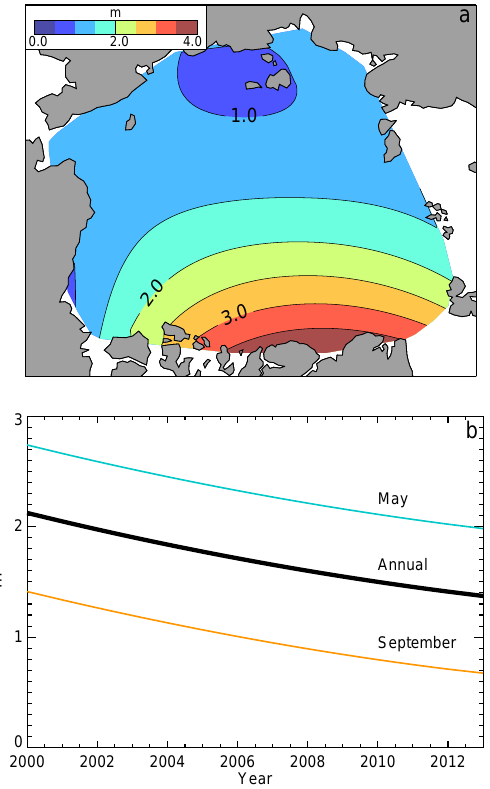
Figure 4. (a) Mean annual ice thickness from the ITRP for the pe- riod 2000–2012. (b) Mean ice thickness for the Arctic Basin in May, in September, and for the annual mean.